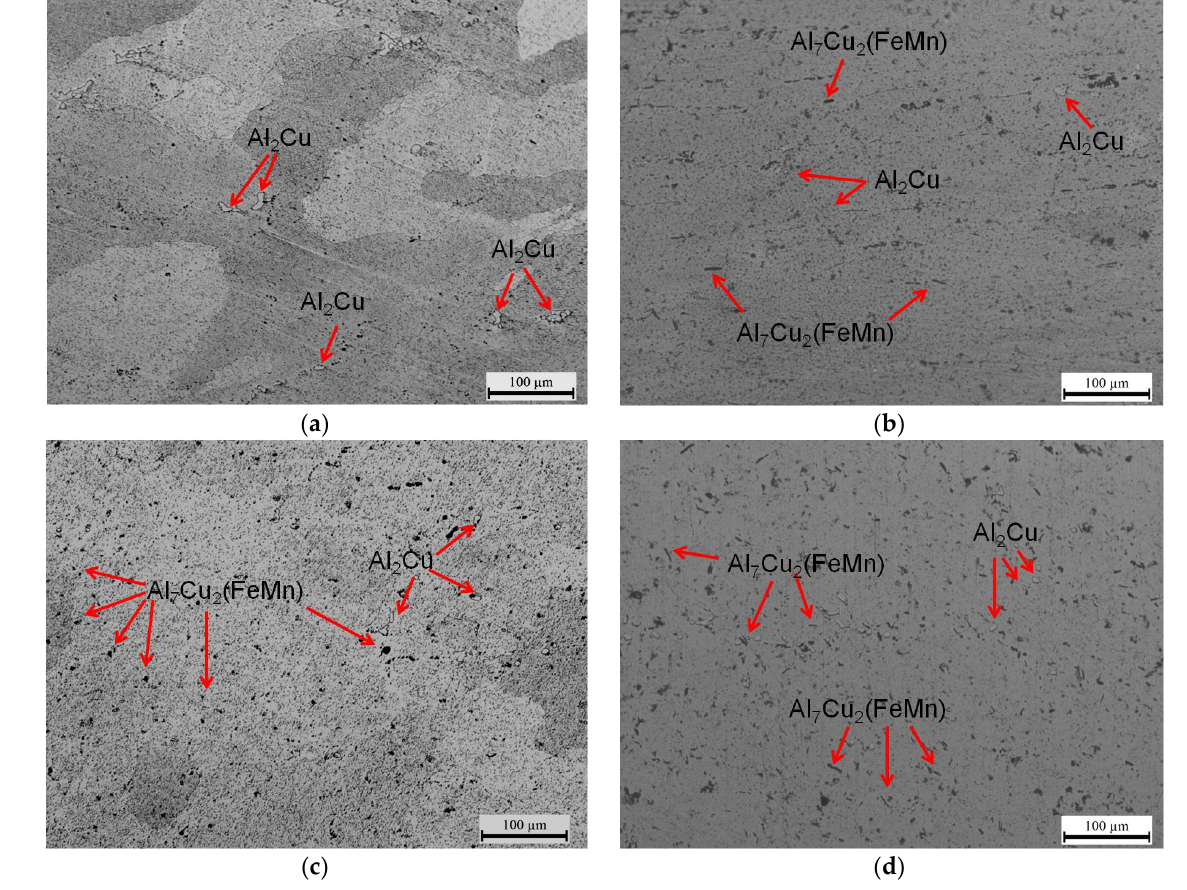
Figure 5. Microstructures of aged alloys with Fe contents: ( a ) 0.03 wt.%; ( b ) 0.1 wt.%; ( c ) 0.15 wt.%; and ( d ) 0.2 wt.%.